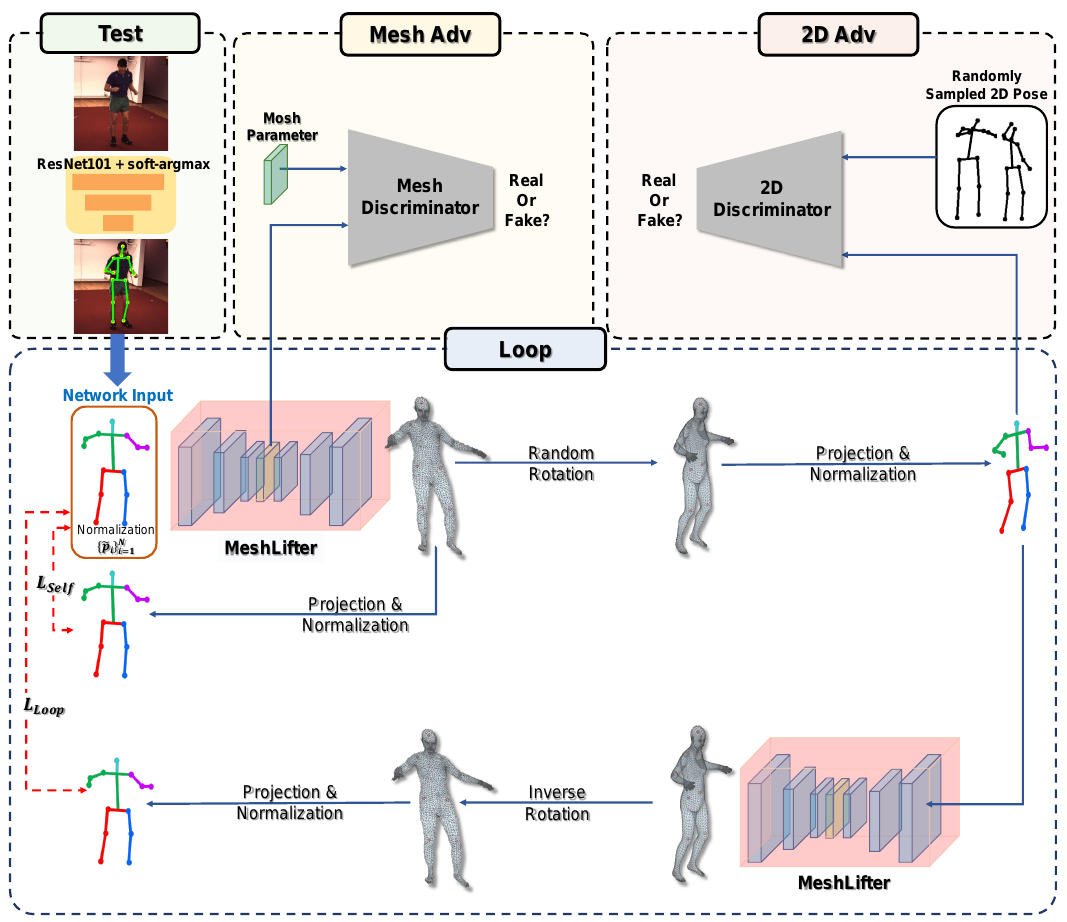
Figure 1. Overview of the proposed